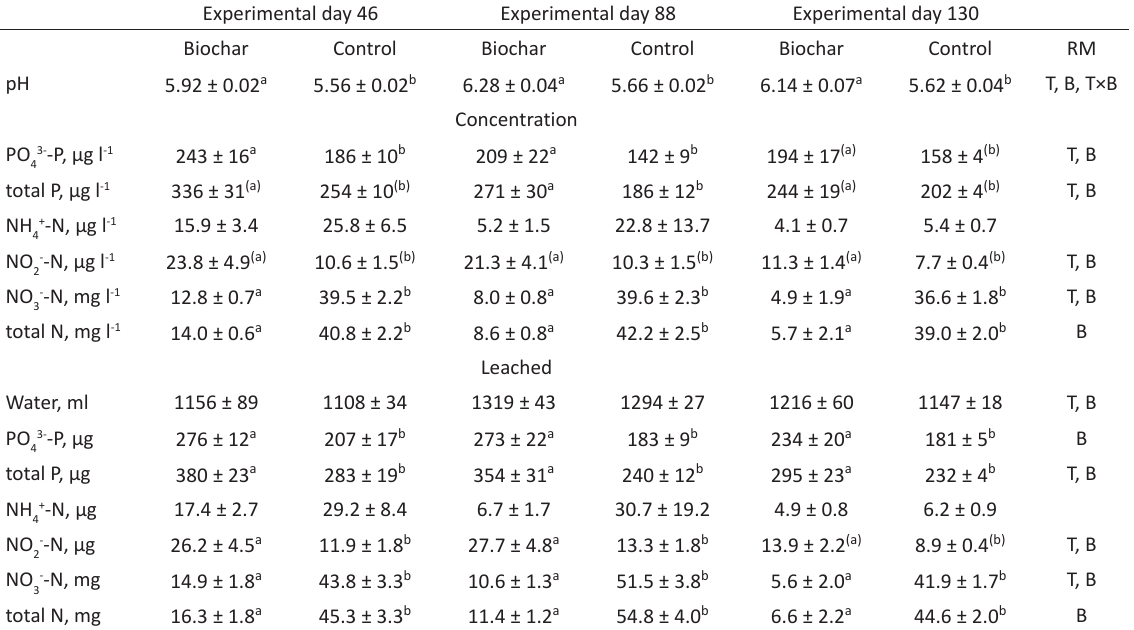
Table 4. Mean (± standard error of mean) concentration in the leached water and the amount of leached nutrients during three sampling occasions on the medium fine sand soil. Small letters indicate significant ( p < 0.05) or in parenthesis indicative (i.e. 0.05 ≤ p < 0.10) differences between biochar treatments during the experimental day in question. RM = repeated measures analysis, significant factors mentioned, T = time, B = biochar, T × B interaction of time and biochar, n